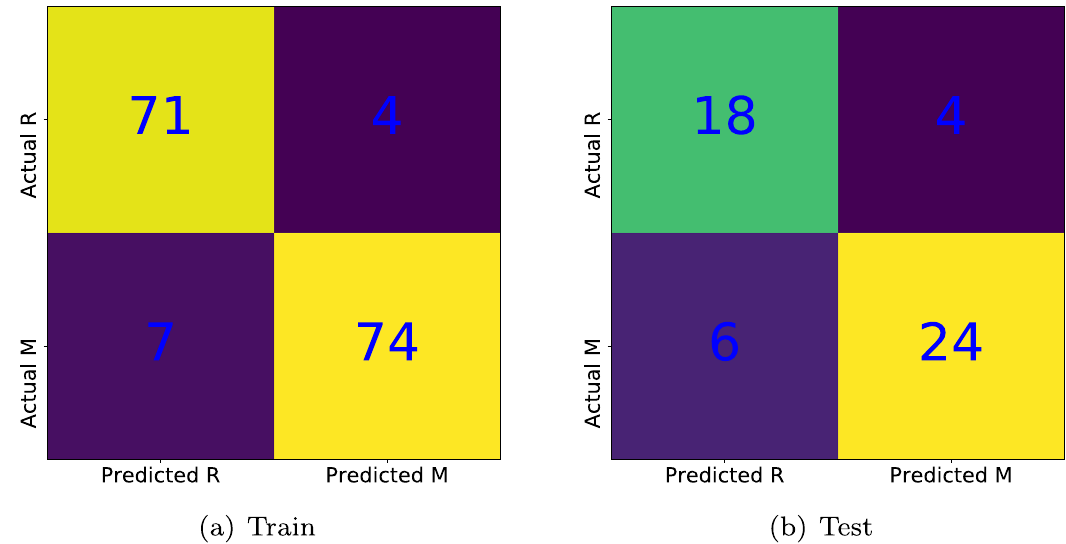
Figure 8. The confusion matrices correspond to the sonar dataset. The accuracies of logistic regression for both train and test datasets are about 0.93 and 0.82, respectively. Note that 187 out of 208 patterns are correctly classified which implies a good classifier with an overall accuracy of about 90% .